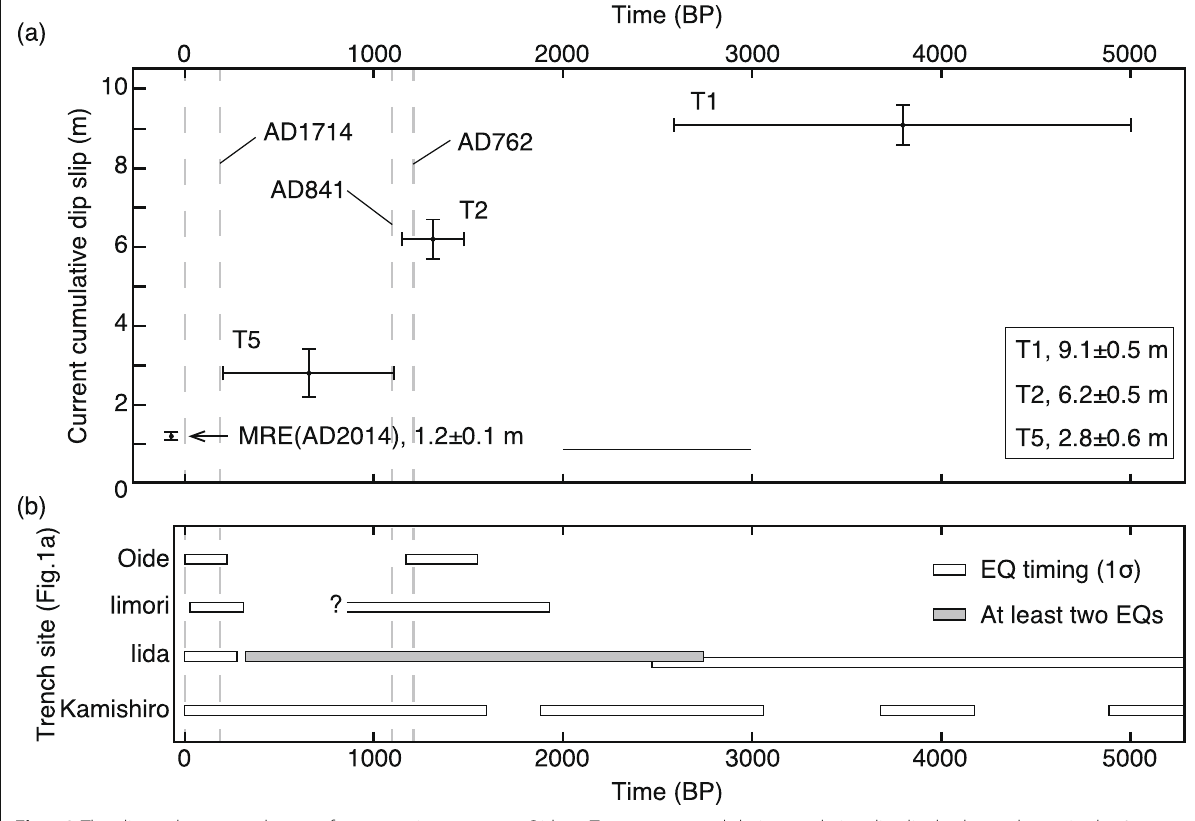
Fig. 10 The slip at the recent three surface-rupturing events at Oide. a Terrace ages and their cumulative dip slip; both are shown in the 2 σ range. Note that the amount of slip in this figure includes that of the 2014 event. b Earthquake timings estimated from paleoseismic trenches. The trench sites are shown in Fig. 1b: Oide and Iida (Toda et al., 2016), Iimori (Katsube et al., 2017a), and Kamishiro (Okumura,